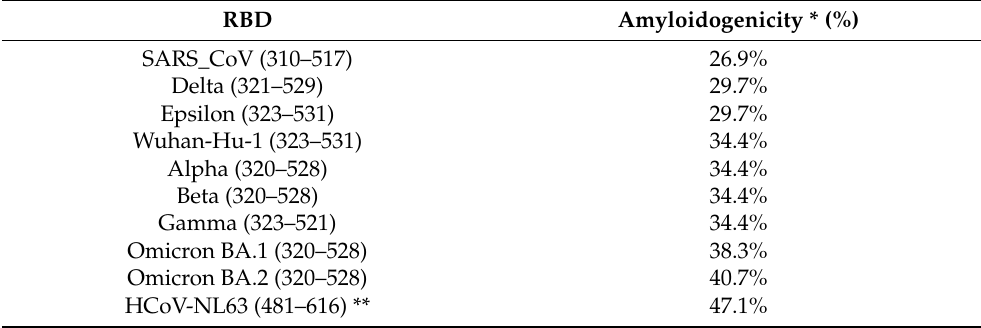
Table 2. Amyloidogenicity of Spike RBDs of various SARS-CoV-2 variants. RBD Amyloidogenicity *